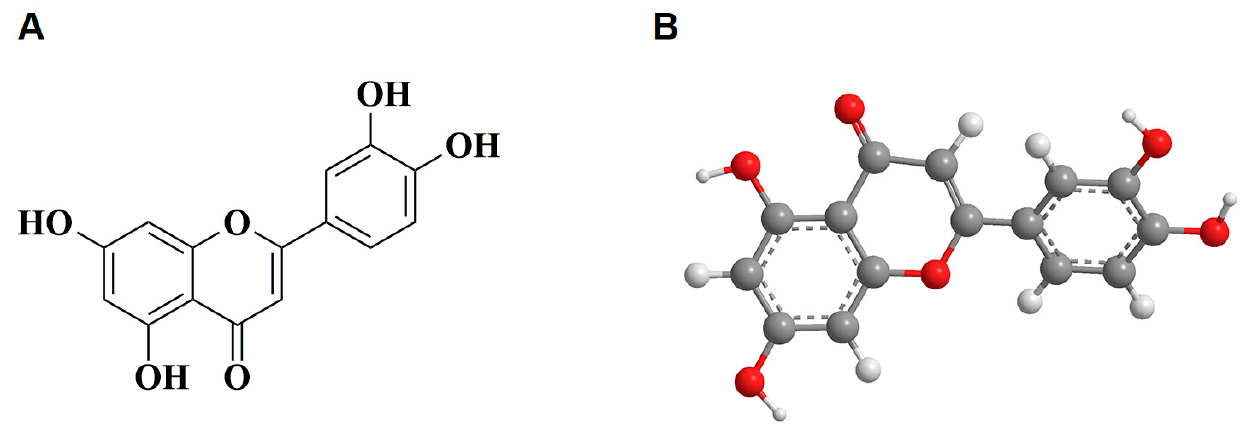
Figure 1. The chemical structure of luteolin. ( A ) The 2D structure of luteolin, ( B ) the 3D structure of luteolin.